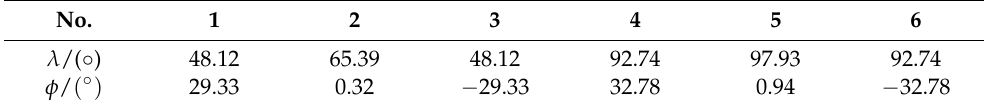
Table 2. The six boundary points of the reachable zone.